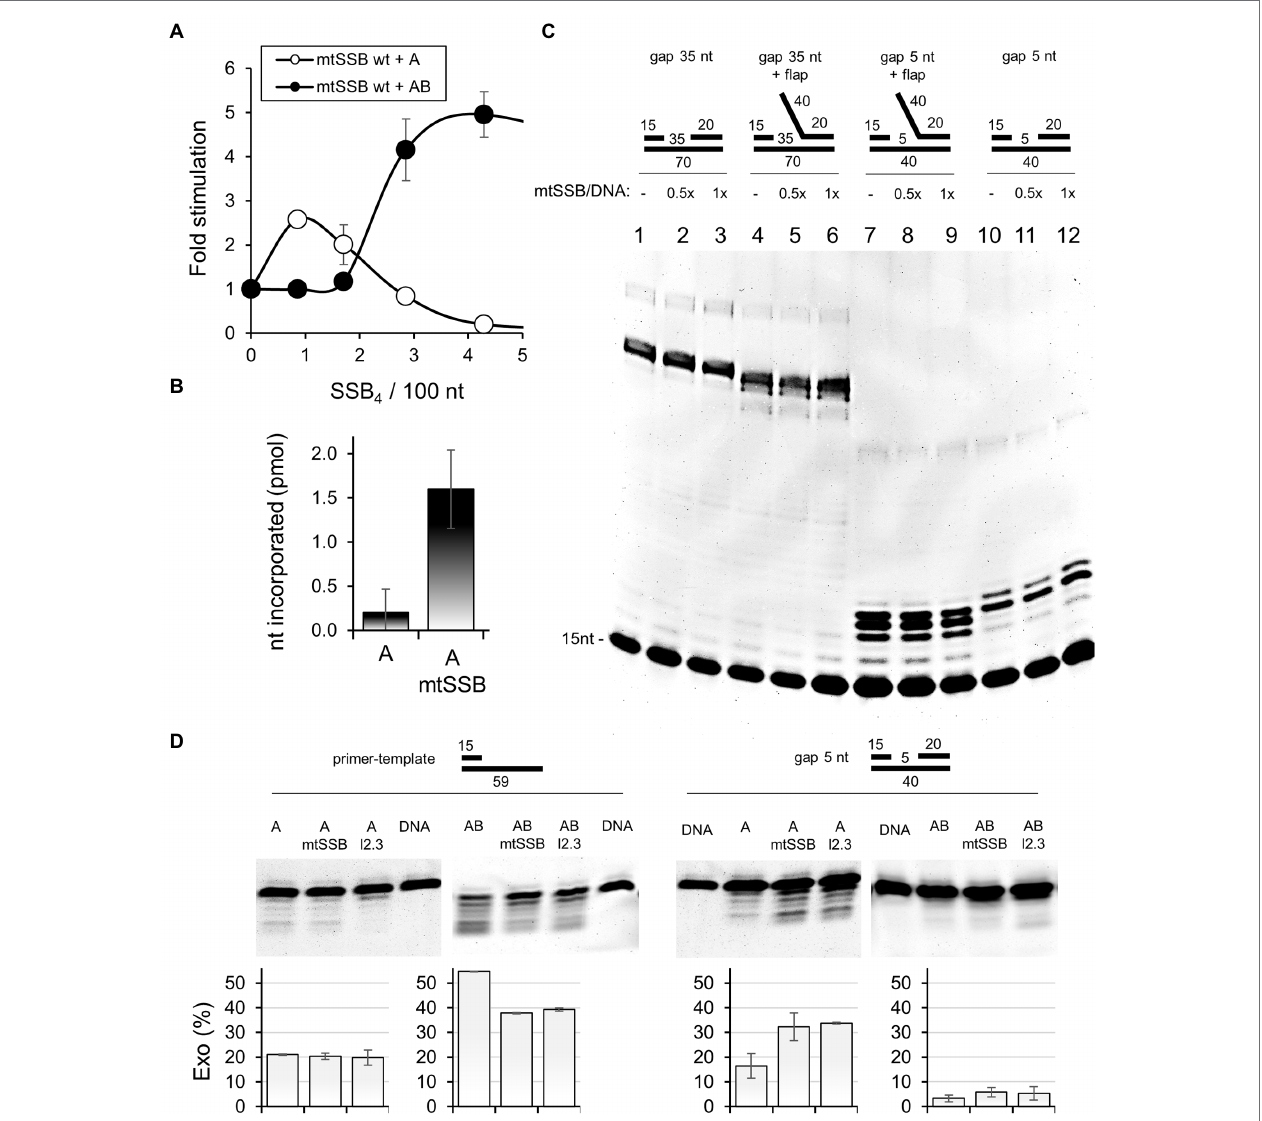
FIGURE 3 | mtSSB stimulates the activity of Pol γα . (A) The processive DNA synthesis assay was performed as described under Materials and Methods, using 55 fmol singly-primed M13 circular DNA (6,407 nt), 20 fmol of Pol γα (A, open circles) or Pol γ holoenzyme (AB, closed circles) and increasing amounts of mtSSB: 0, 3, 6, 10, and 15 pmol. Assays were performed at 30 mM KCl and 4 mM MgCl 2 . The data represent the mean of three experiments, ±SD. The results were normalized to the amount of nucleotide incorporated by Pol γα or Pol γ holoenzyme in the absence of mtSSB (arbitrarily set to 1 in each case). (B) Nucleotide incorporation on DNase I-activated calf thymus DNA was assessed as described under Materials and Methods, using Pol γα (A), in the presence or absence of mtSSB, as indicated. The data represent the mean of three experiments, ±SD. (C) The single gap assay was performed as described under Materials and Methods in the absence or presence of 10 or 20 nM mtSSB 4 , represented as their molar ratio to available binding sites on the DNA substrate (mtSSB/DNA). DNA substrates with a 5 or 35 nt gap, with or without a 40 nt flap were used as indicated. Products of reactions were analyzed by denaturing polyacrylamide gel electrophoresis. The gel image is representative of three independent analyses. (D) The exonuclease assay was performed as described under Materials and Methods, using Pol γα (A) or Pol γ holoenzyme (AB), in the presence or absence of 20 nM mtSSB 4 or mtSSB l2.3 . DNA substrate with a 5 nt gap, or primer-template (15/59) were used as indicated. Products of reactions were analyzed by denaturing polyacrylamide gel electrophoresis. The relative abundance of the products of exonucleolysis was estimated by densitometry and the mean of three independent experiments (±SD) is presented in the graphs